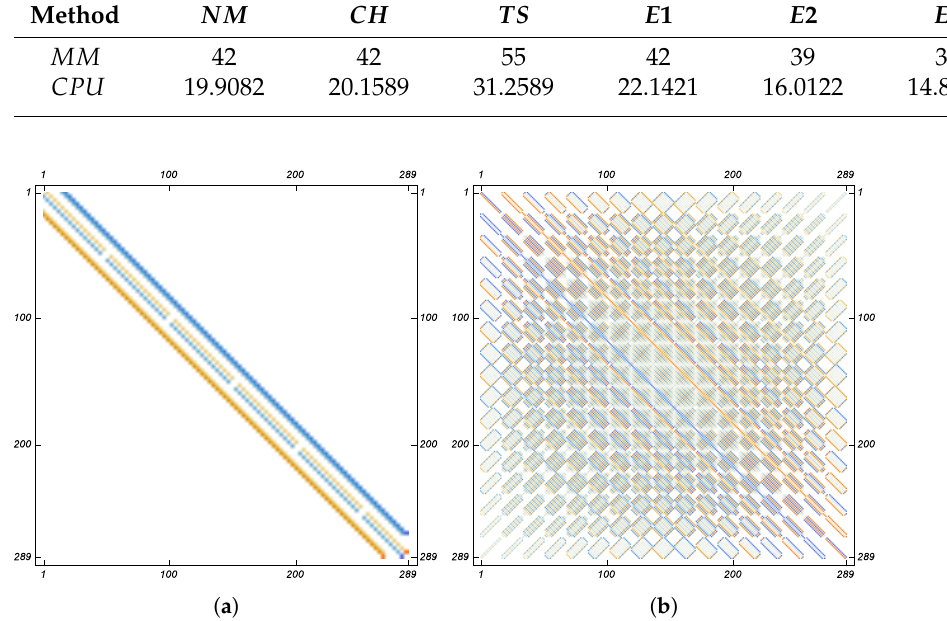
Table 8. Results of Example (6) case (b).